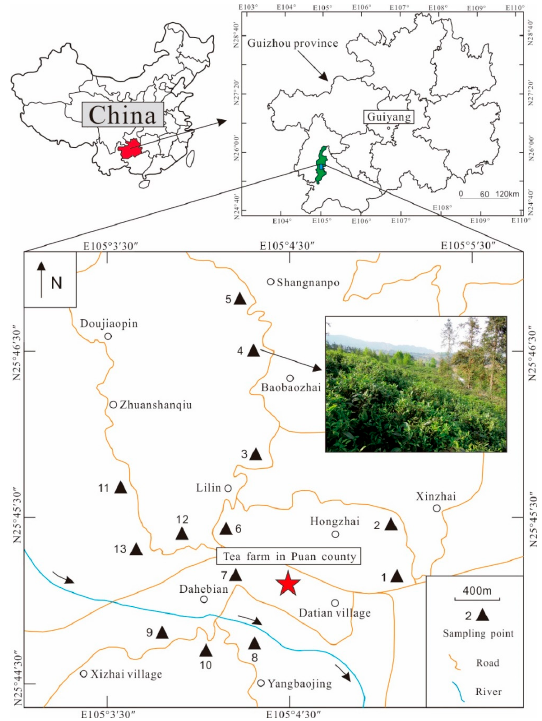
Figure 1. Study area and location of the sampling points for soil and corresponding tea leaves collection.